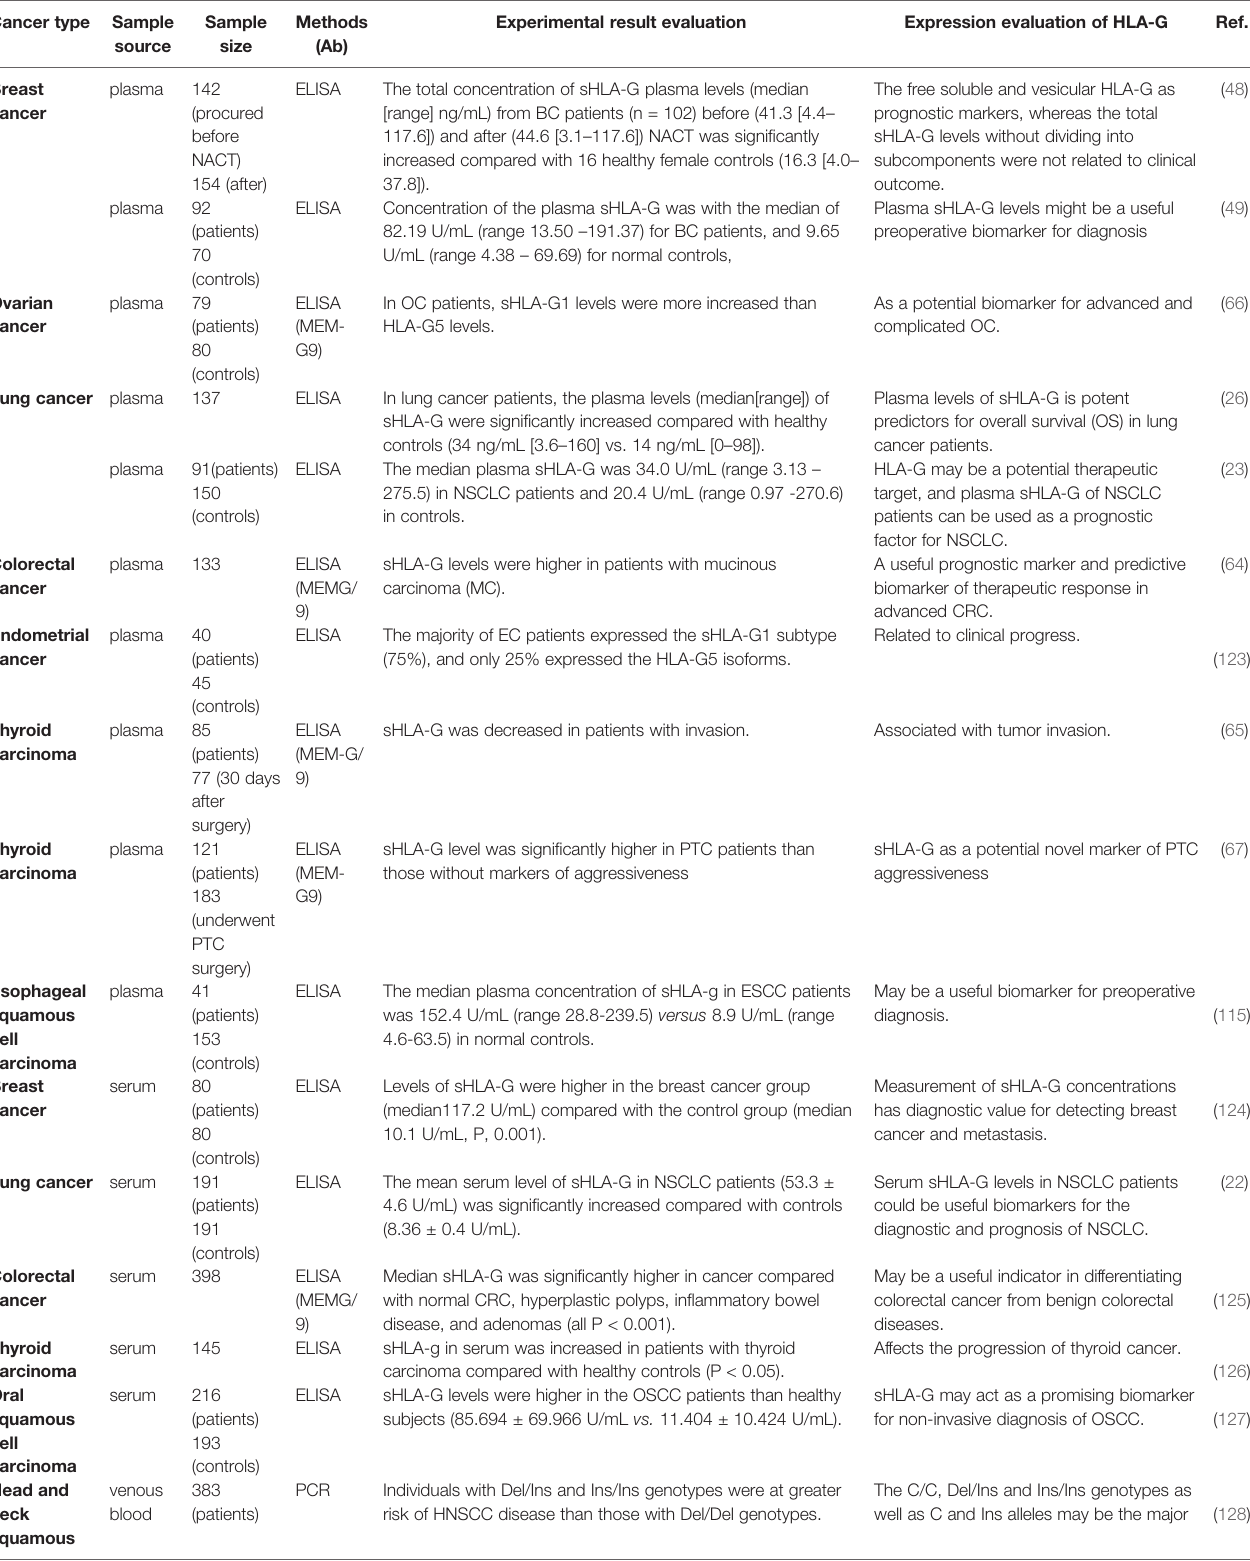
TABLE 1 | Clinical research involving diagnosis and prognosis of sHLA-G in the blood. Cancer type Sample